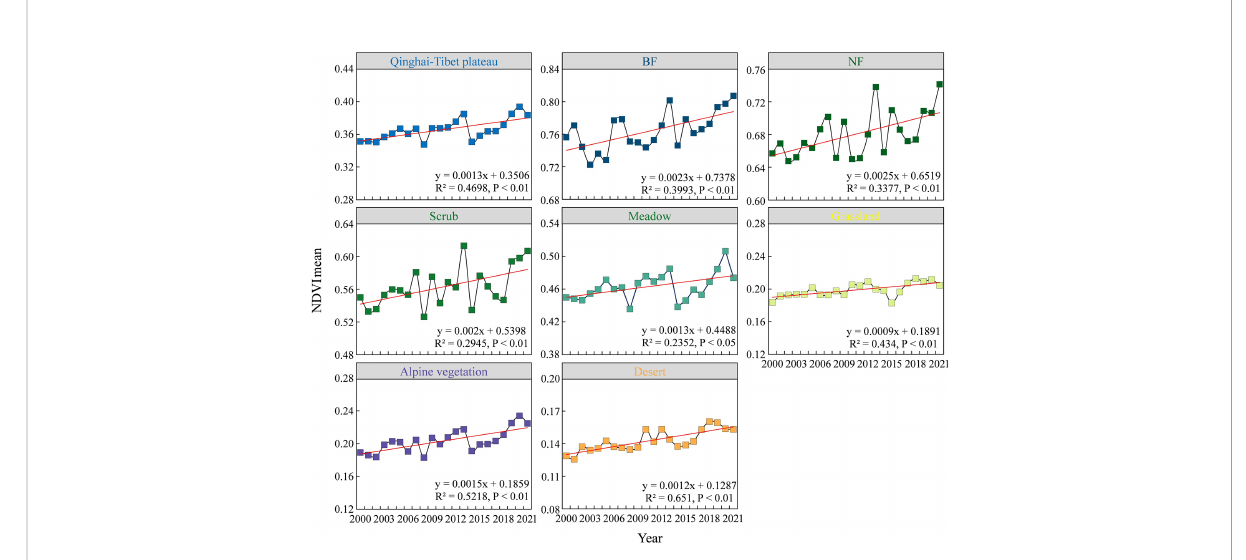
FIGURE 2 Mean greenness changes of entire Qinghai-Tibetan Plateau and seven vegetation